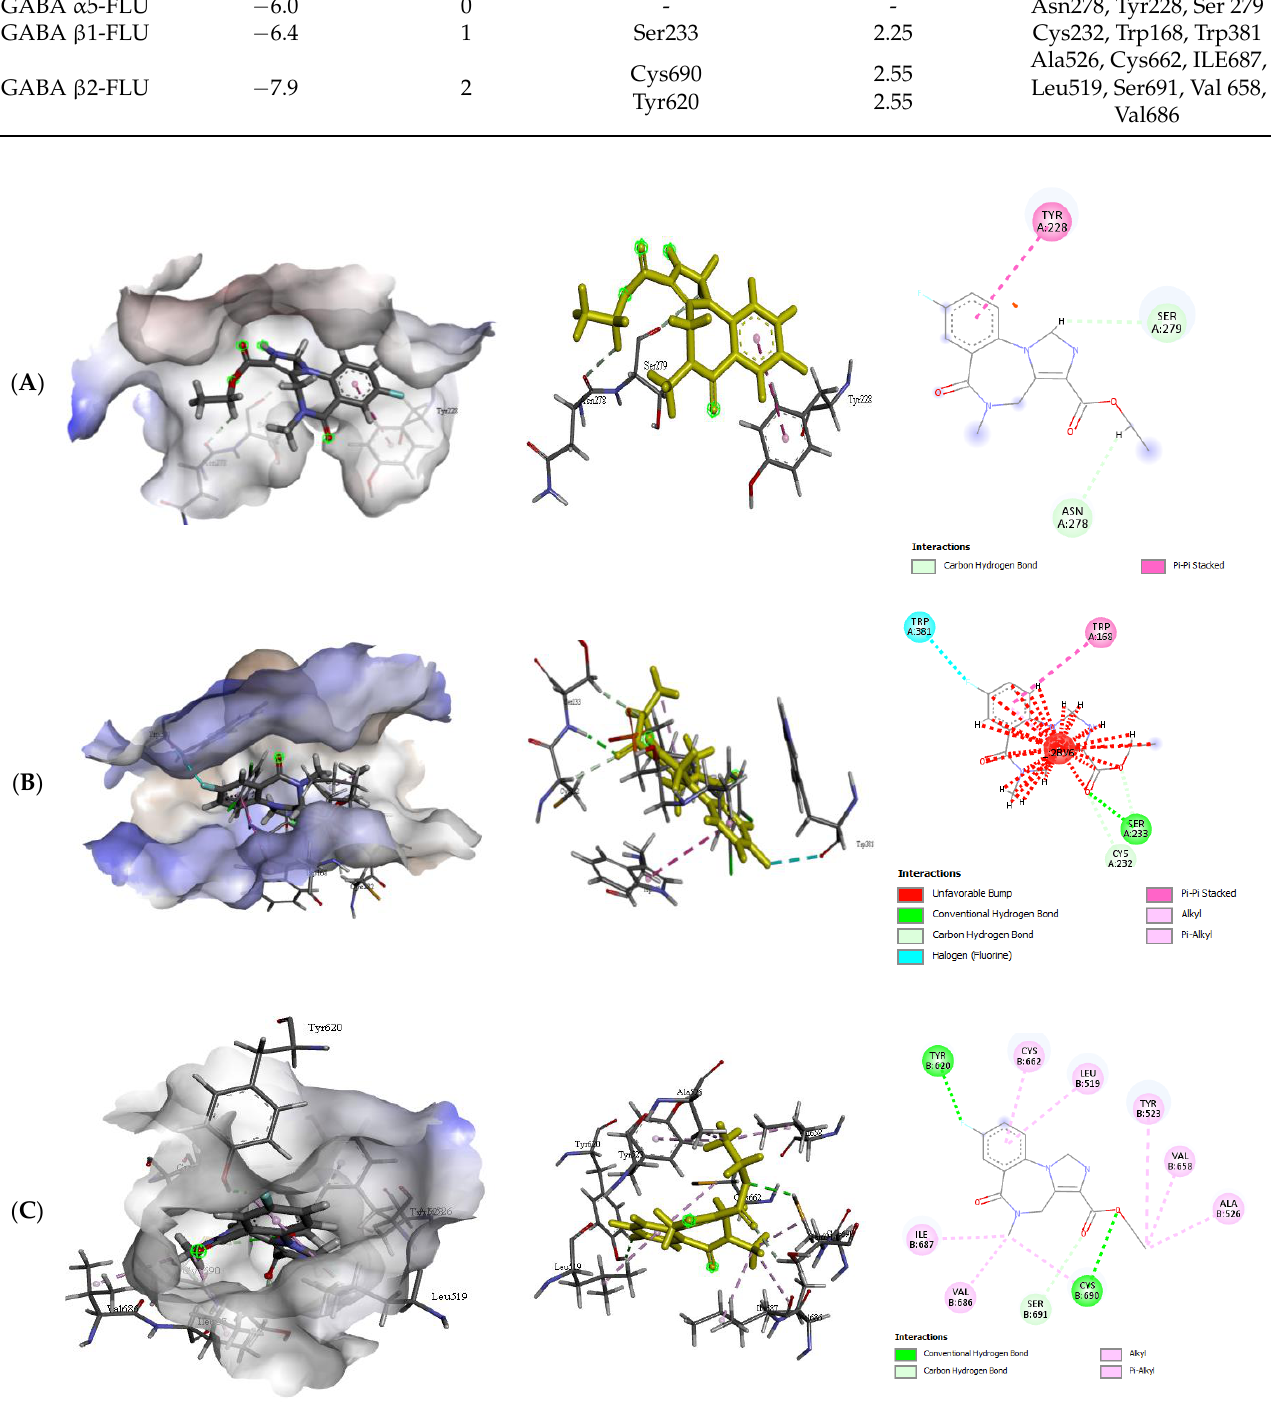
Figure 5. The 2D and 3D structure of molecular docking interactions of ( A ) GABA (α5), ( B ) GABA (β1), and ( C ) GABA (β2) receptor with quercetin (QUR). Table 7. The best three results of molecular docking study of flumazenil (FLU) with GABA receptor subunits.